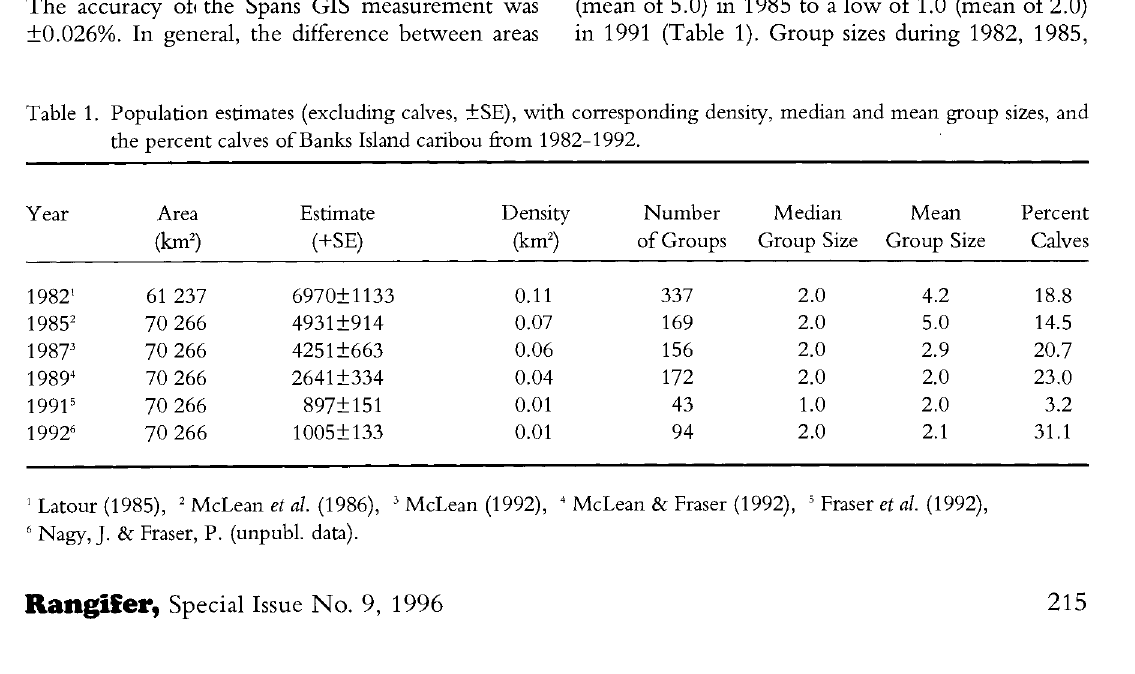
Table 1. Population estimates (excluding calves, +SE), with corresponding density, median and mean group sizes, and the percent calves of Banks Island caribou from